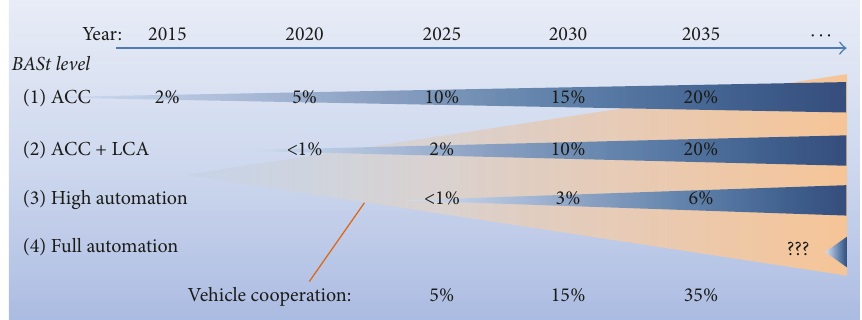
Figure 1: Estimated automated vehicle share on